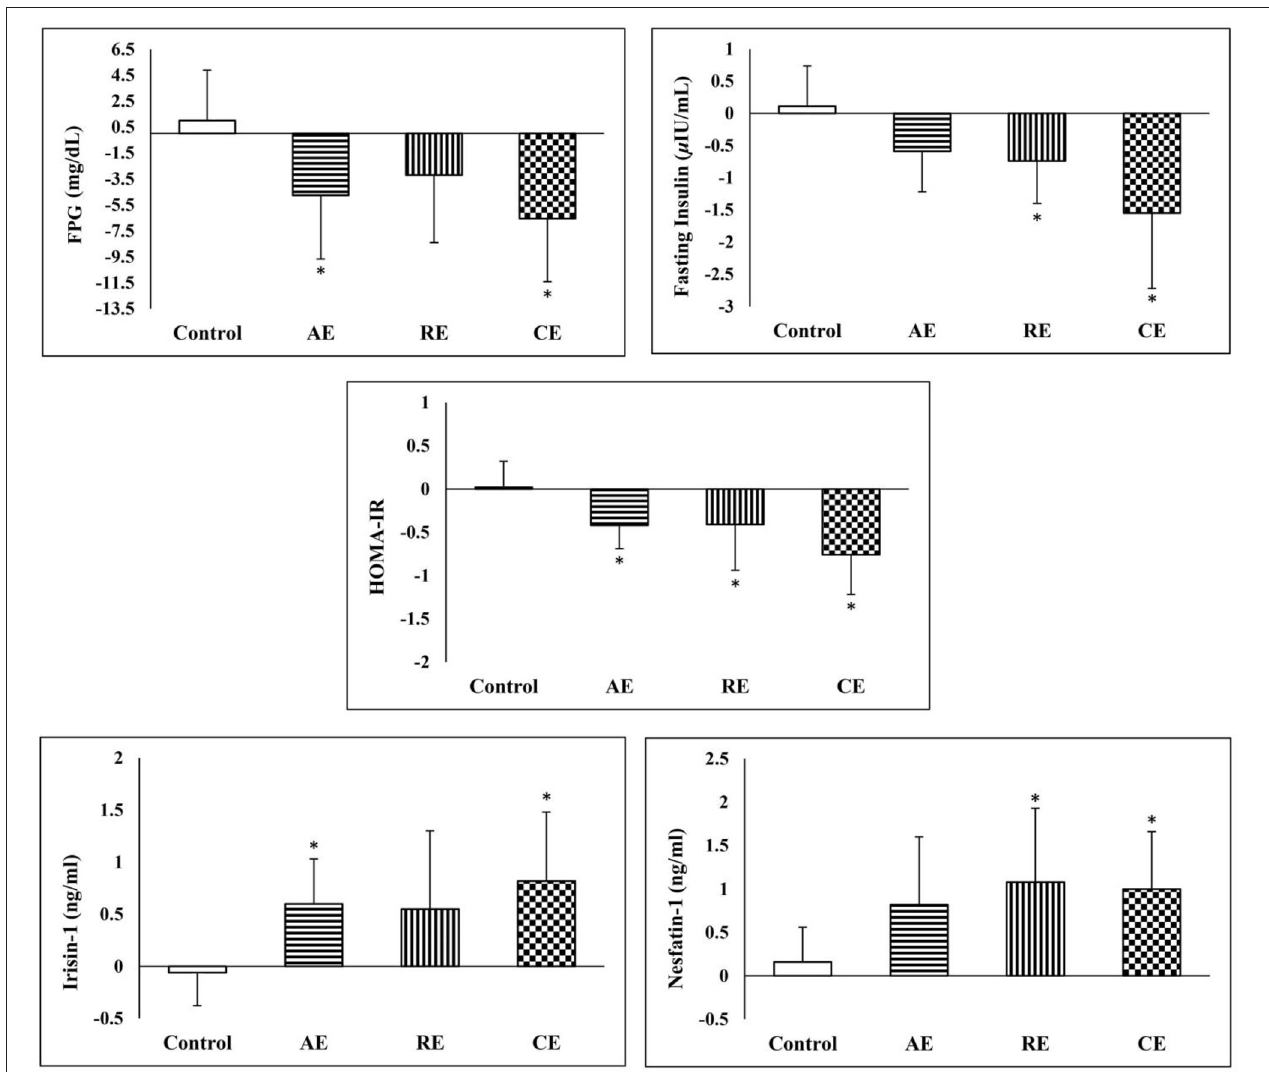
FIGURE 4 | Comparison of changes in glycemic indices Irisin-1 and nesfatin-1 between the groups. *Significant difference in comparison with the control group ( p < 0.05). AE, aerobic exercise; RE, resistant exercise; CE, combined